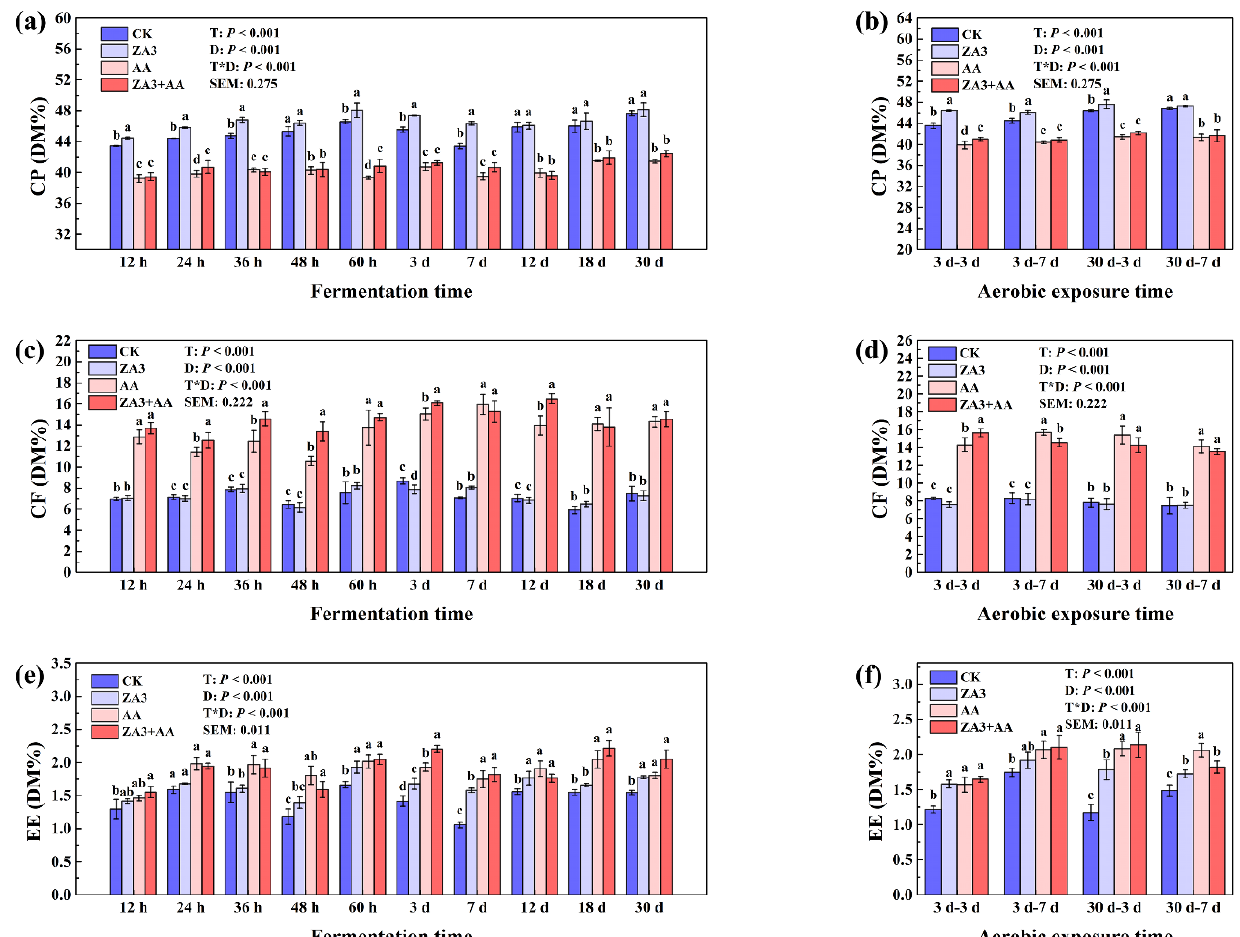
Figure 3. Chemical composition of FSBM during fermentation and aerobic exposure. ( a , b ), CP, crude protein; ( c , d ), CF, crude fiber; ( e , f ), EE, ether extract; DM, dry matter. Different lowercase letters (a – d) for the same treatment time indicate significant differences ( p < 0.05) among different treatment groups according to the Student – Newman – Keuls test. The significant difference between days and treatment interactions is expressed as p < 0.001. h, hours; d, days.